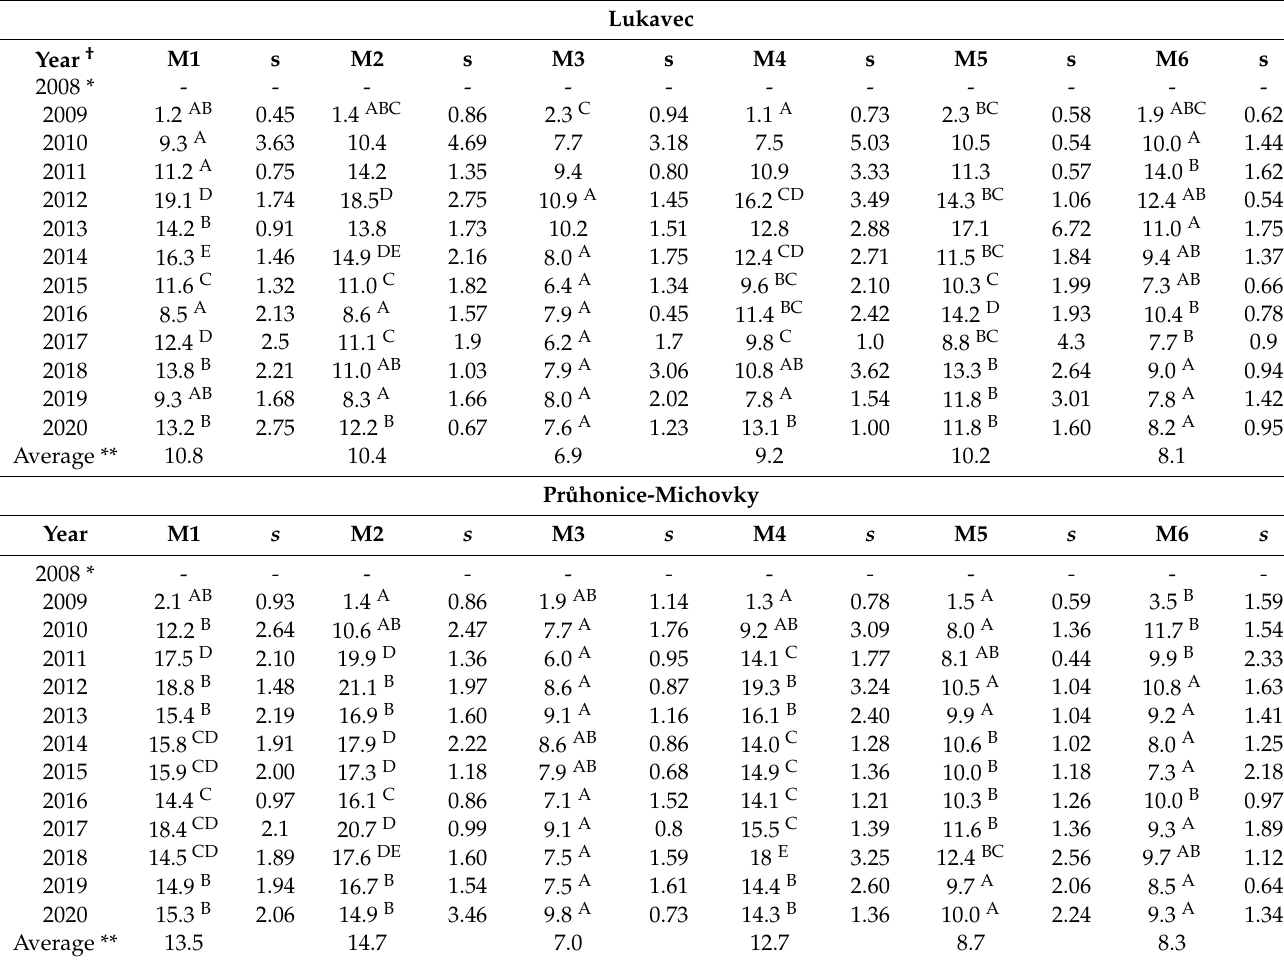
Table legend: s—standard deviation; * yield was not evaluated due to slow growth in the year of the experiment establishment (2007); † considered as financial years from January to December (e.g., yield from spring harvest in 2008 represents biomass from the 2007 vegetative period); A–E indexed capital letters show results of statistical analysis of yields of tested clones in individual years (MANOVA–Duncan; homogenous groups); ** average yields from 12 harvests are calculated for 13 years of the